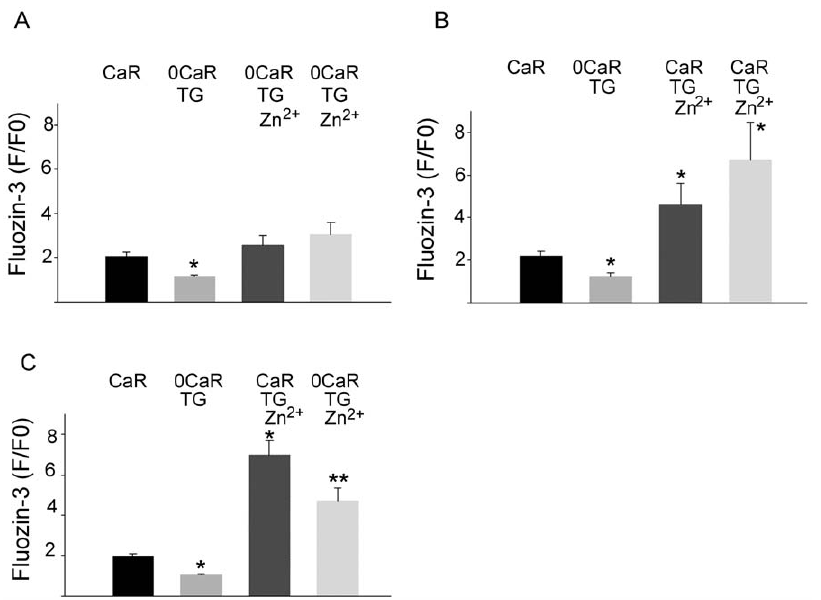
Figure 6. Influence of Ca 2 + availability on uptake of Zn 2 + by populations of isolated gastric glands. Studies were performed to determine whether plate-reader-based measurements were capable of detecting Ca 2 + -dependent changes in [Zn 2 + ] i . Rabbit gastric glands were pre- loaded with fluozin-3AM for 45 mins. Aliquots of glands (N=6 each group) were transferred to 96 well plates ( , 2,000/well) coated with polylysine to promote adherence. Solutions were exchanged with fresh solutions at the intervals noted below to assess response of Zn 2 + loading when intracellular Ca 2 + stores had been depleted. Fluorescence intensity was measured at the end of each treatment and compared to baseline measurements under control conditions (F/F 0 where baseline is set at arbitrary ratio 2.0). Measurements reported as means 6 SEM. (* p , 0.001 ** p , 0.05 compared to baseline Ringer’s measurements in each set). Panel 6A: Measurements of [Zn 2 + ] i in gastric gland preparations exposed, in sequence, to Ca-Ringer’s (15 mins); 0Ca-Ringer’s-thapsigargin (35 mins); 0Ca-Ringer’s-10 m M Zn (30 mins); 0Ca-Ringer’s-10 m M Zn (an additional 30 mins). Panel 6B: Measurements of [Zn 2 + ] i in gastric gland preparations exposed, in sequence, to Ca-Ringer’s (15 mins); 0Ca-Ringer’s (35 mins)- thapsigargin; Ca-Ringer’s-10 m M Zn (30 mins); Ca-Ringer’s 10 m M Zn (an additional 30 mins). Panel 6C: Measurements of [Zn 2 + ] i in gastric